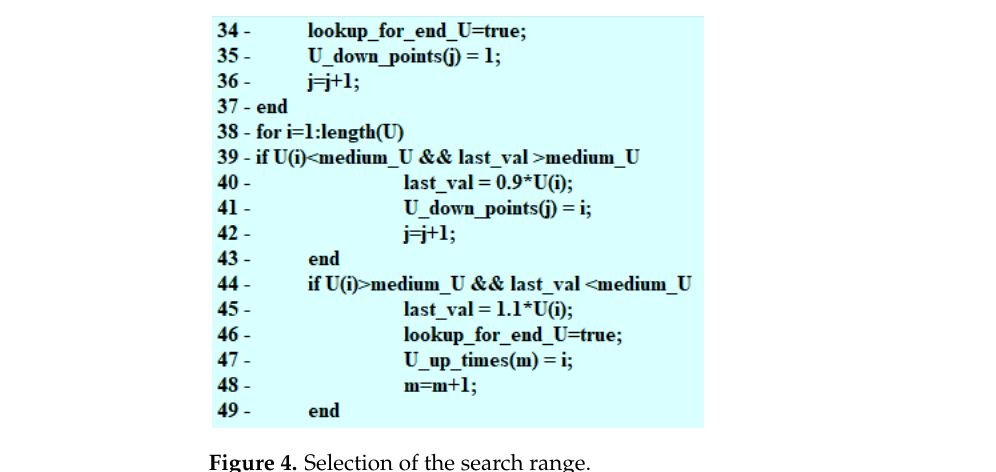
Figure 7. Finding the local minimum of the current intensity. Subsequently, the time reading at the point of the PWM signal beginning is compared to the time at the point of the needle lifting. On the basis of the difference between two times, the value of delay in the moment of starting the fuel flow is determined (Figure 8). Figure 8. Final part of the search for the needle lifting phase. As feedback for the user, the program gives the value of the current intensity at the point of the opening of the fuel flow as well as the time that lapsed between the moment of the PWM signal beginning and opening of the fuel flow. These results are presented in